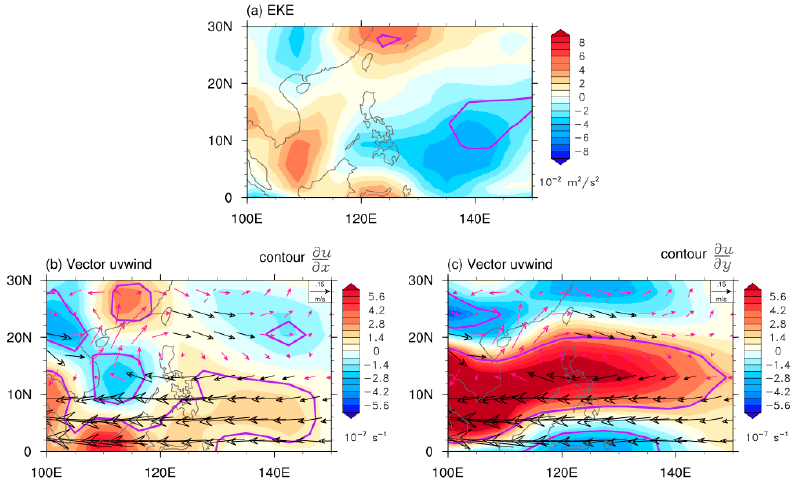
Figure 9. Difference in: ( a ) EKE; and the ( b ) zonal and ( c ) meridional gradient of zonal wind between warm and cold northwest Indian Ocean SST simulations using SPEEDY. In ( b , c ), vectors are the difference in horizontal wind at 850 hPa; black vectors indicate better than the 0.05 significance level.